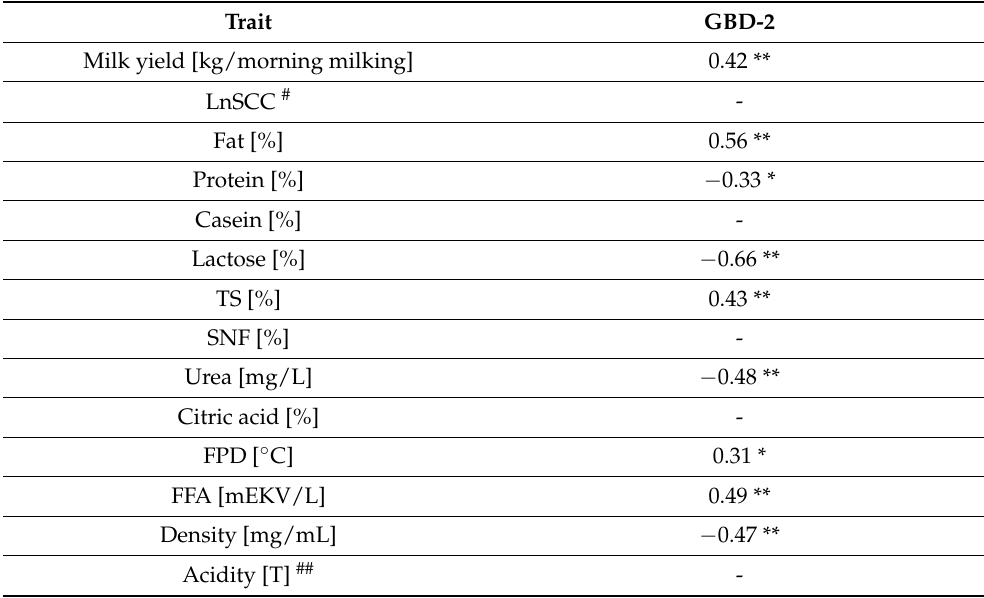
Table 4. Correlations between beta-defensin concentrations in milk with components and yield. Trait GBD-2 Milk yield [kg/morning